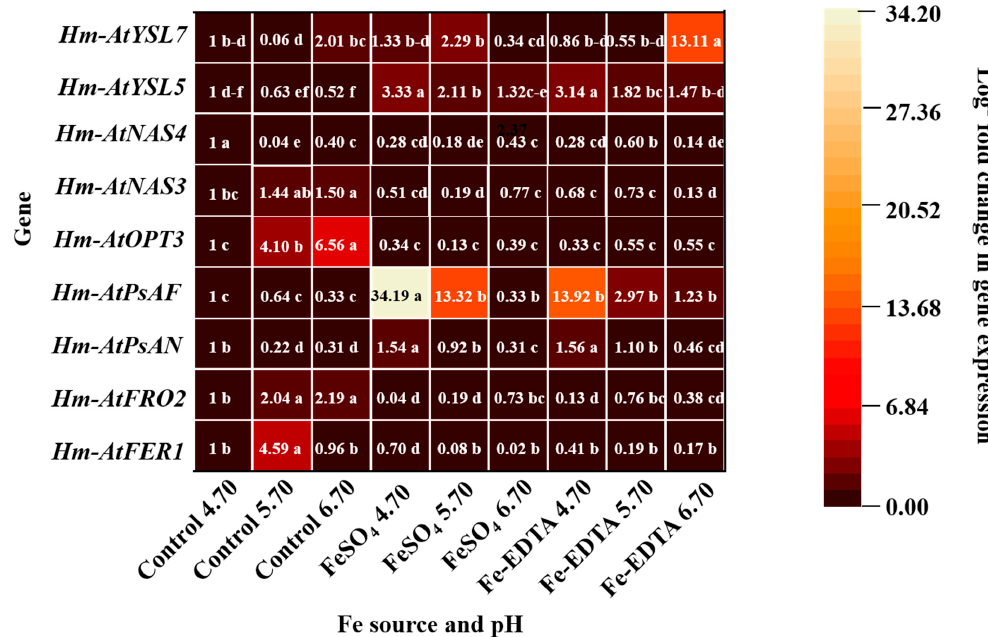
Figure 9. Expression profiles heat map of ferritin 1 ( FER1 ), ferric reductase 2 ( FRO2 ), photosystem I reaction center subunit N ( PsAN ), photosystem I subunit F ( PsAF ), oligopeptide transporters 3 ( OPT3 ), nicotianamine synthase 3 ( NAS3 ), NAS4 , yellow stripe-like 5 ( YSL5 ), and YSL7 in H. macrophylla after 60 days of culture. The gene expression is presented with a scale of fold change calculated by 2 − ∆∆ CT . Lowercase letters indicate significant differences calculated by Duncan’s multiple range test at p ≤ 0.05.